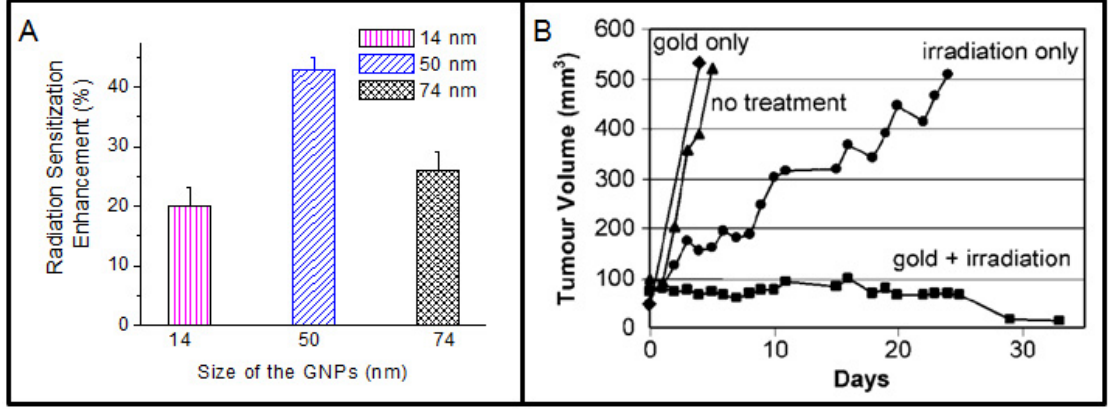
Figure 4. Radiation enhancement properties of GNPs. ( A ) Variation of cell survival fraction as a function of size of the GNPs ( i.e ., 10% survival, 220 kVp). ( B ) Average tumor volume after: no treatment (triangles); gold only (diamonds); irradiation only (30 Gy, 250 kVp, circles); intravenous gold injection (1.35 g Au / kg) followed by irradiation (squares). Reproduced with permission